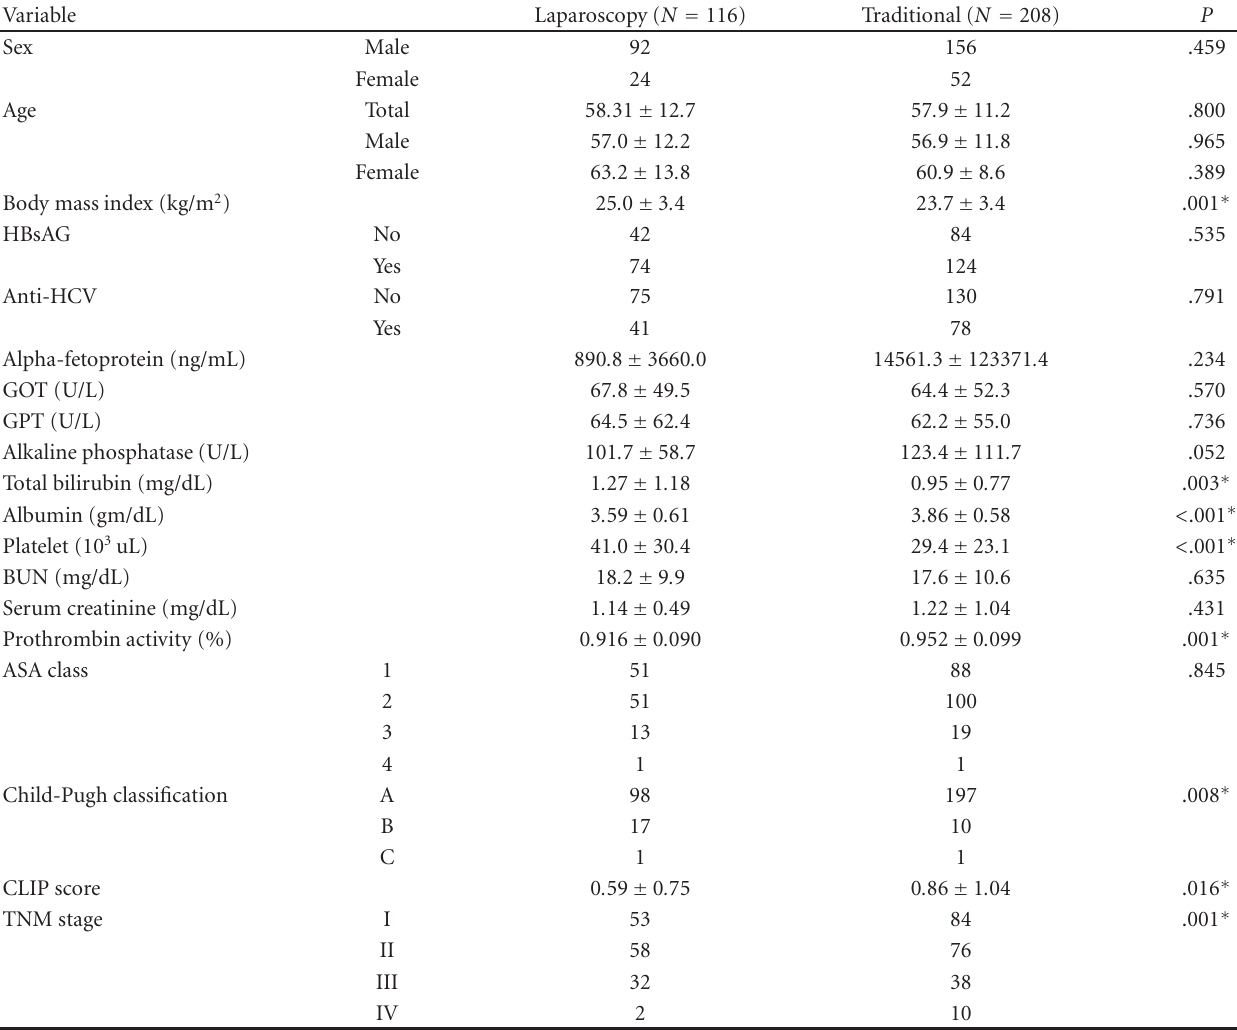
Table 1: Preoperative clinical demographic data.